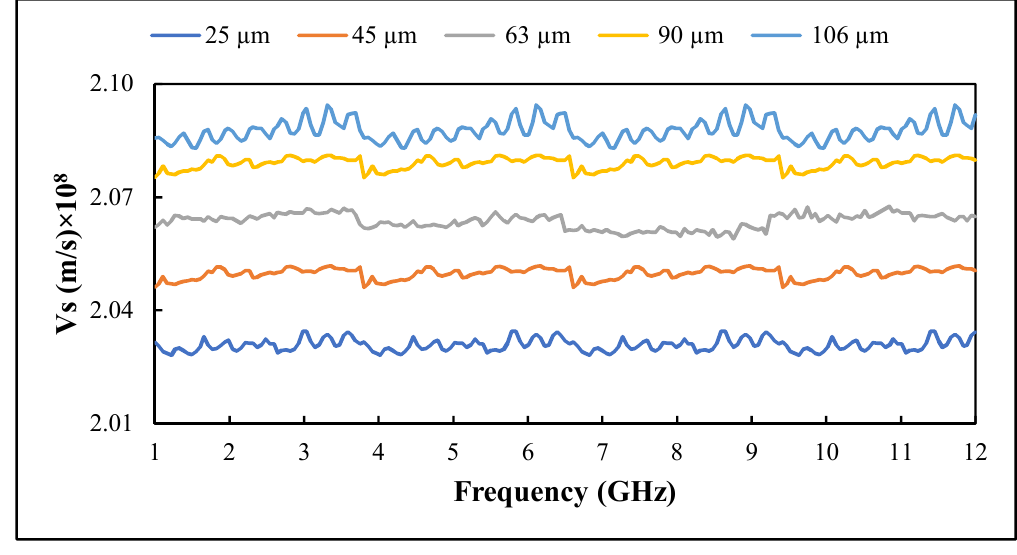
Figure 12. Variation of signal transmission speed with filler size.